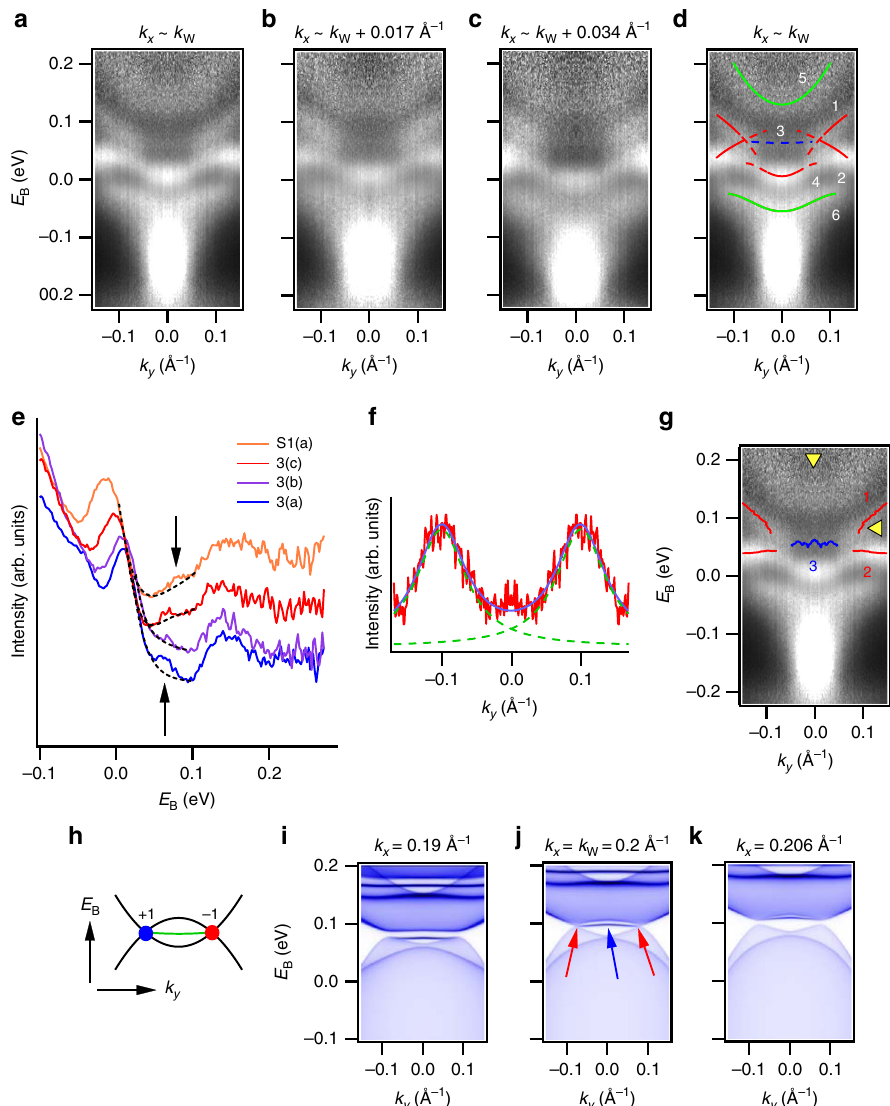
Fig. 3 Weyl points and Fermi arcs above the Fermi level in TaIrTe 4 . a – c Pump probe ARPES spectra of TaIrTe 4 , showing dispersion above E F at fi xed k x expected to be near the Weyl points. d Same spectrum as a but with key features marked. The Weyl cone candidates are labeled 1 and 2, the Fermi arc candidate is labeled 3. e Energy distribution curves ( EDCs ) through the Fermi arc at k x ~ k W , k W + 0.017 Å − 1 , k W + 0.034 Å − 1 , and k W + 0.045 Å − 1 . The dotted black lines are fi ts to the surrounding features, to emphasize the Fermi arc peak, marked by the black arrows . We observe signatures of the upward dispersion of the Fermi arc with increasing k x , consistent with ab initio calculations and basic topological theory. f An MDC with two large peaks corresponding to the upper Weyl cones. The dotted green lines show an excellent fi t of the peaks to Lorentzian functions. g Same spectrum as a , but with key features marked by a quantitative fi ts to EDCs and MDCs. The yellow arrows correspond to the location of the EDCs in e and the MDC in f . h Cartoon of the cones and arc observed in the data, showing what is perhaps the simplest con fi guration of Weyl points and Fermi arcs that can exist in any Weyl semimetal. i – k Ab initio calculation of TaIrTe 4 showing the Weyl points ( red arrows ) and Fermi arc ( blue arrow ). The excellent agreement with calculation suggests that we have observed a Weyl semimetal in TaIrTe